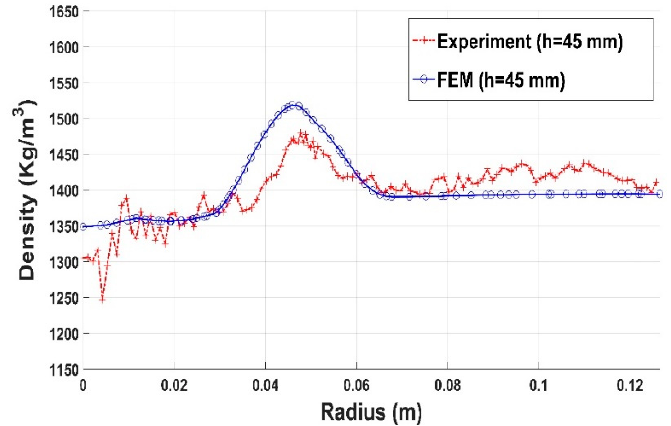
Figure 31. Density profile along the radius (slot): experiment vs. finite element result (h = 45 mm).